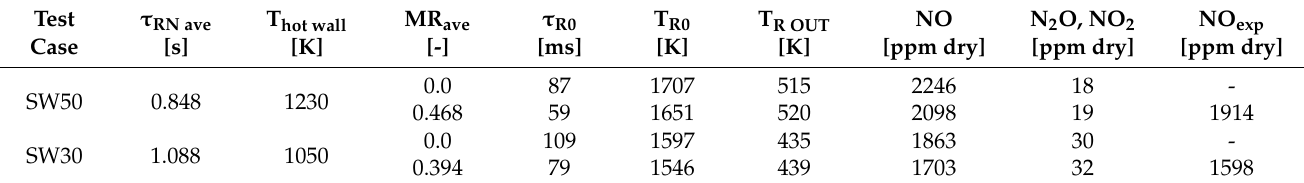
Figure 11. Comparison of kinetic reaction mechanisms in a function of ammonia share in fuel with Table 5. Influence of the recirculation ratio on the NO concentration, 5%NH 3 Φ = 0.71, Li